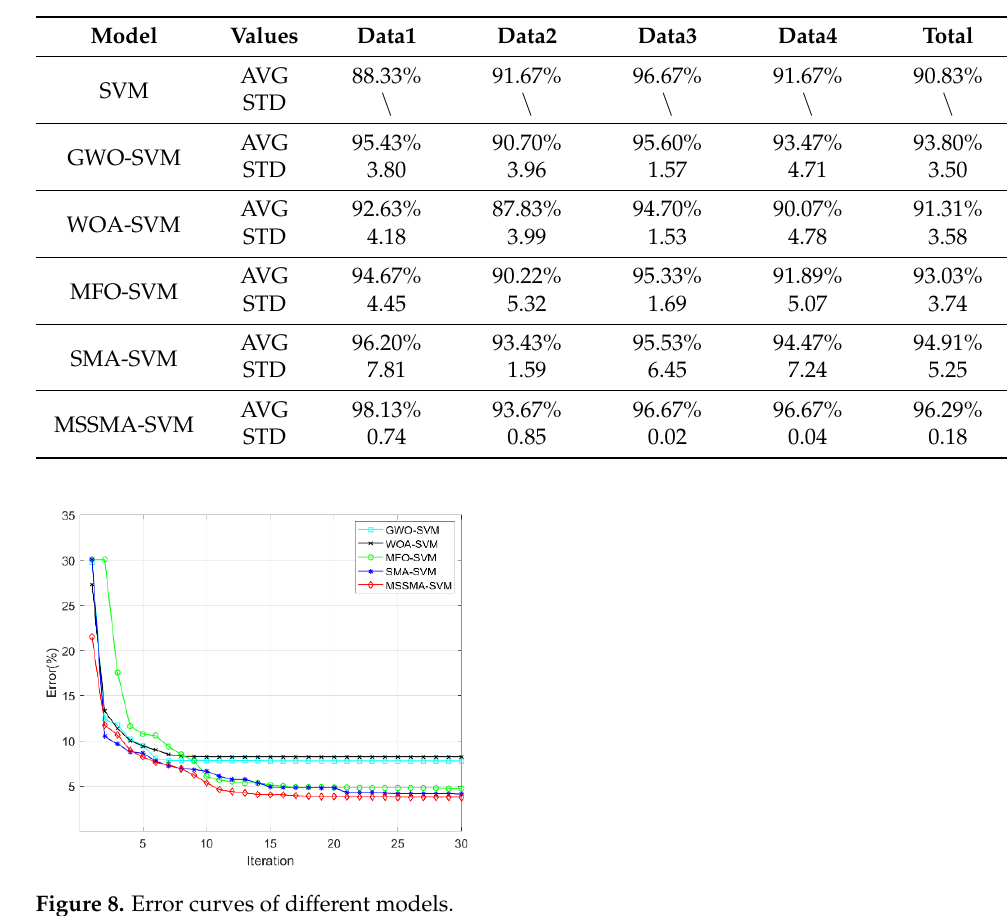
Table 3. Classification results of different models.